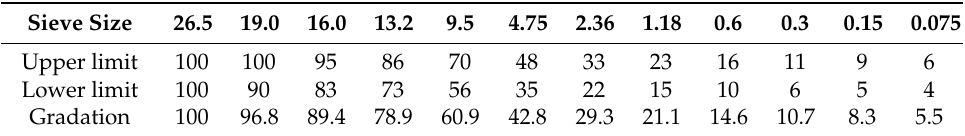
Table 6. Gradation AC20 asphalt mixture.